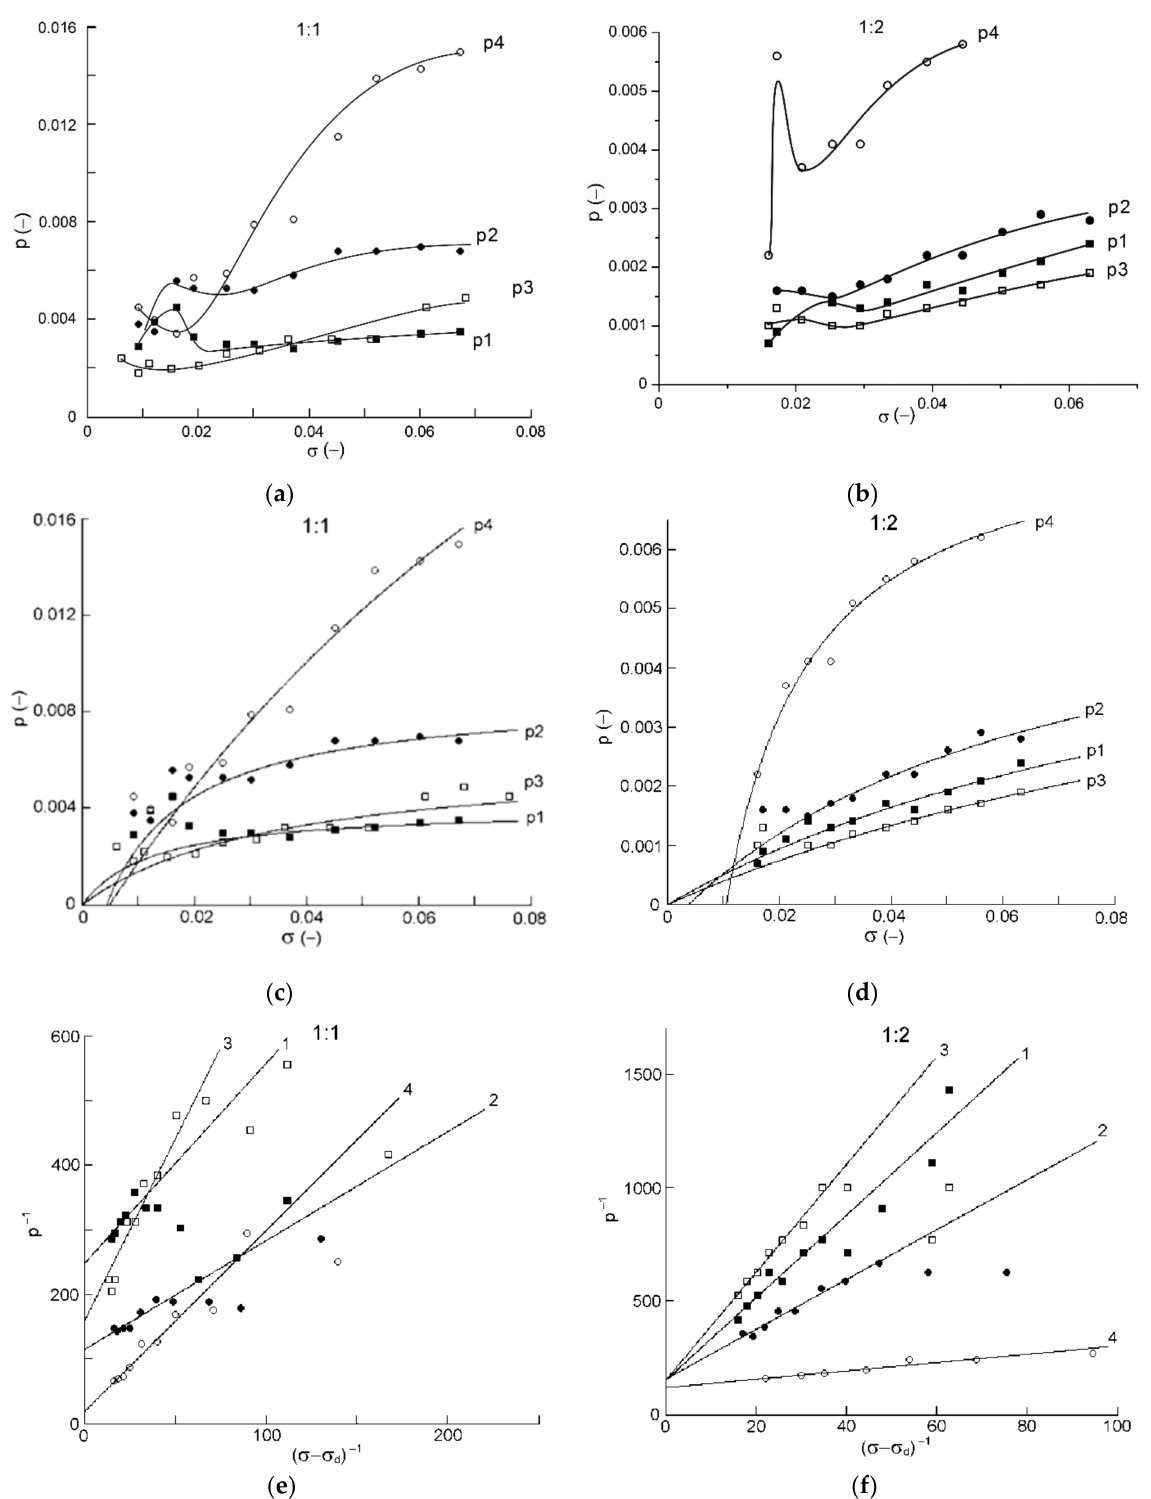
Figure 4. Steepness of the sectors of growth hillocks on the (110) face as a function of supersaturation in solutions: ( a , c ) 1:1; and ( b , d ) 1:2, (morphology of the hillock is shown in Figure 2). Panels ( c , d ) present fitting curves plotted according to Expression (8) (the values of fitting parameters are given in Table 1). Panels ( e , f ) show plots 1/ p i against 1/( σ − σ d_i ) drawn for the p i ( σ ) dependences in panels ( c , d ). Instrumental error of the p i measurements is within the size of the experimental